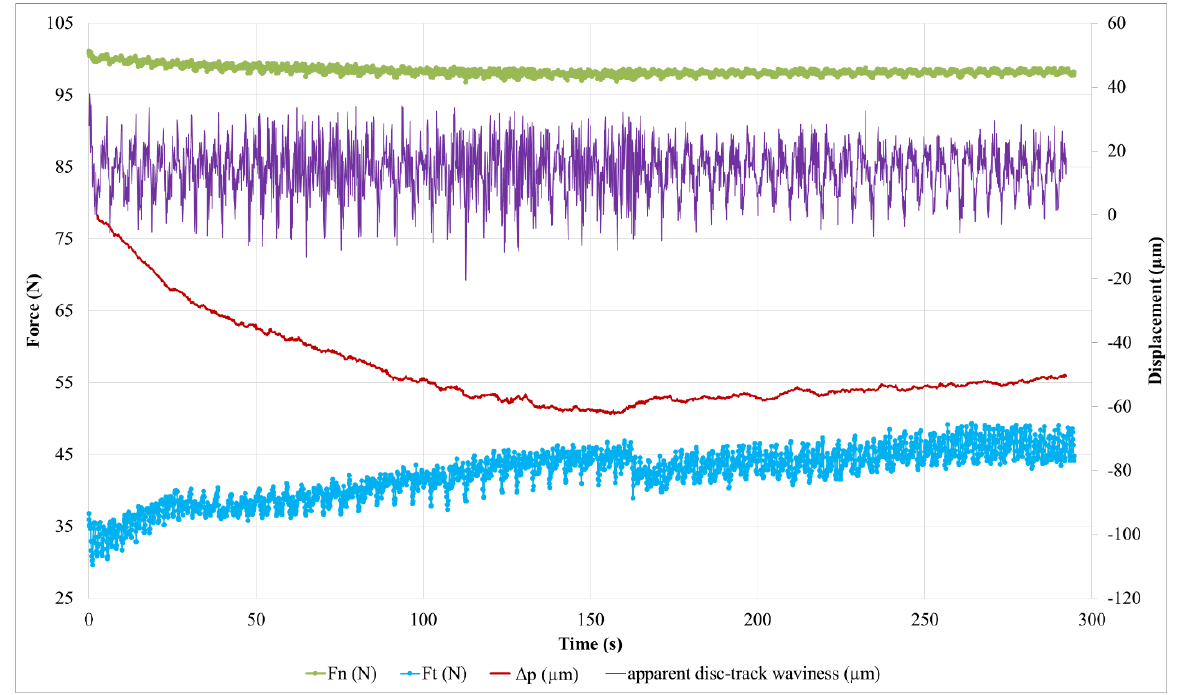
Figure 15. Evolution of contact forces, pin displacement (∆p) and apparent disc track waviness during the friction test for material M2.